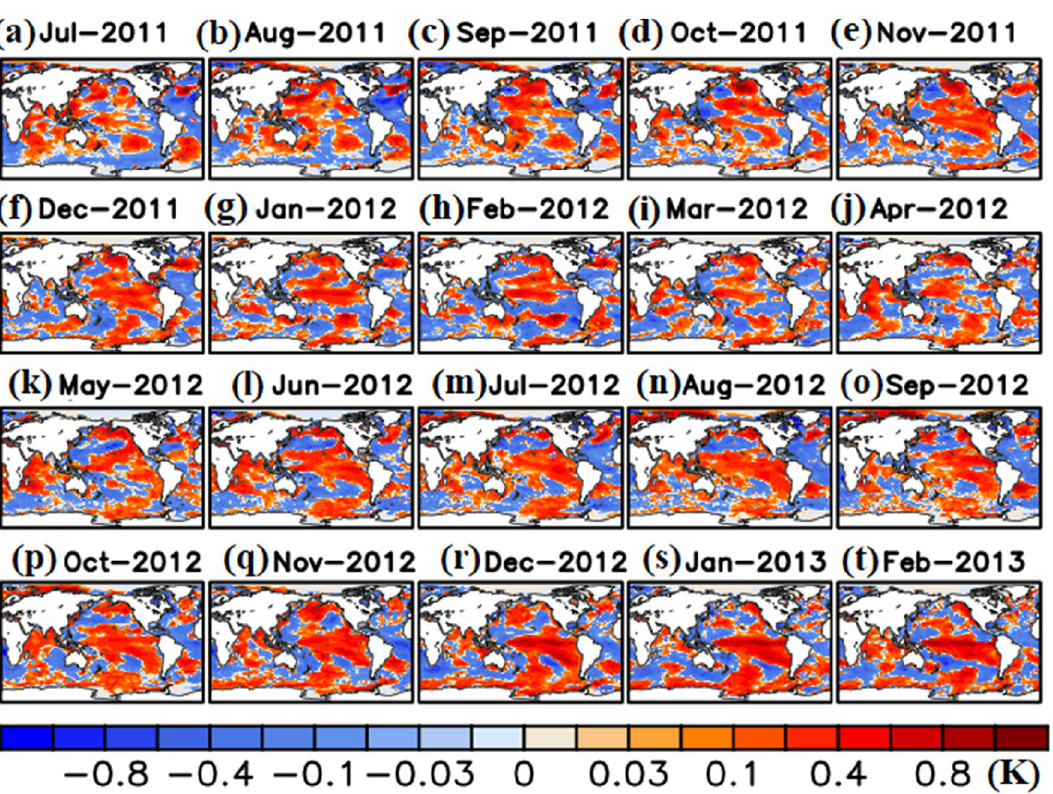
Figure 5. Anomalies (Vol-CTL) in temperature of sea water (K) from MPI-ESM ( a )-( t ) from July 2011 to February 2013. (Figure created using the COLA/GrADS